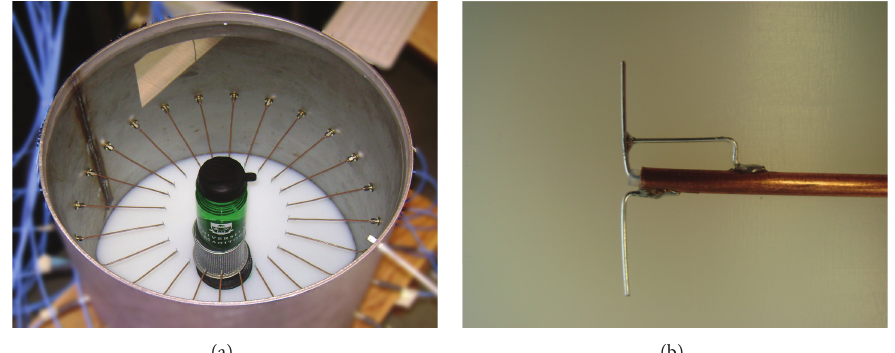
Figure 1: (a) The MWI system metallic enclosure with a glycerol-/water-based imaging phantom. (b) A dipole antenna with quarter wave- length